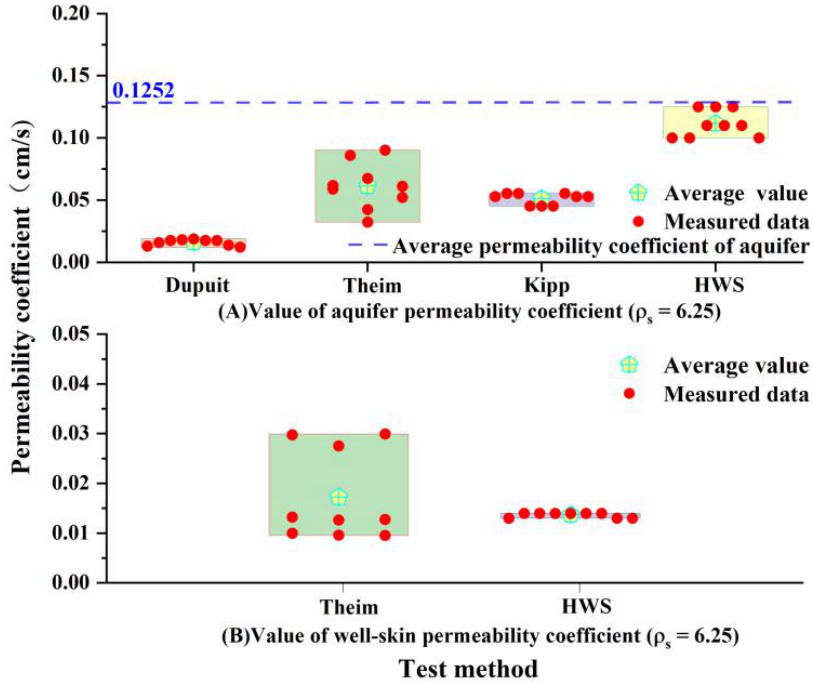
Figure 12. Calculation results of permeability coefficients of aquifer and well-skin layers for each analytical method for ρ s = 6.25 (20 cm thick positive well-skin layer) (The different colour blocks represent the calculated value range of permeability coefficient under different methods).